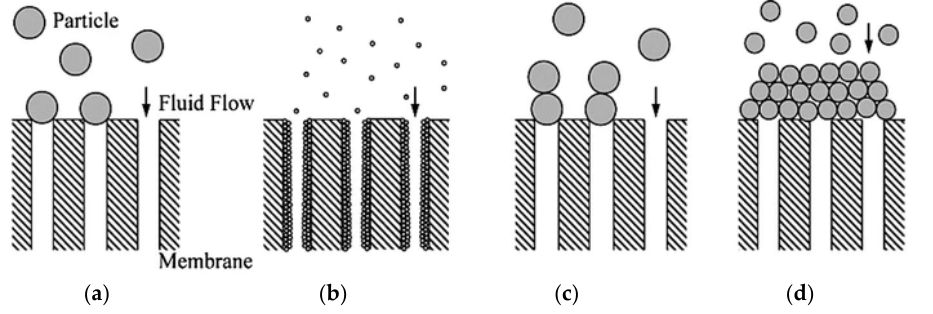
Figure 3. Illustration on membrane blockage by retained molecule: ( a ) complete blocking, ( b ) standard blocking, ( c ) intermediate blocking, and ( d ) cake filtration. Reprinted from [76] with permission from Taylor & Francis Ltd. 2013.